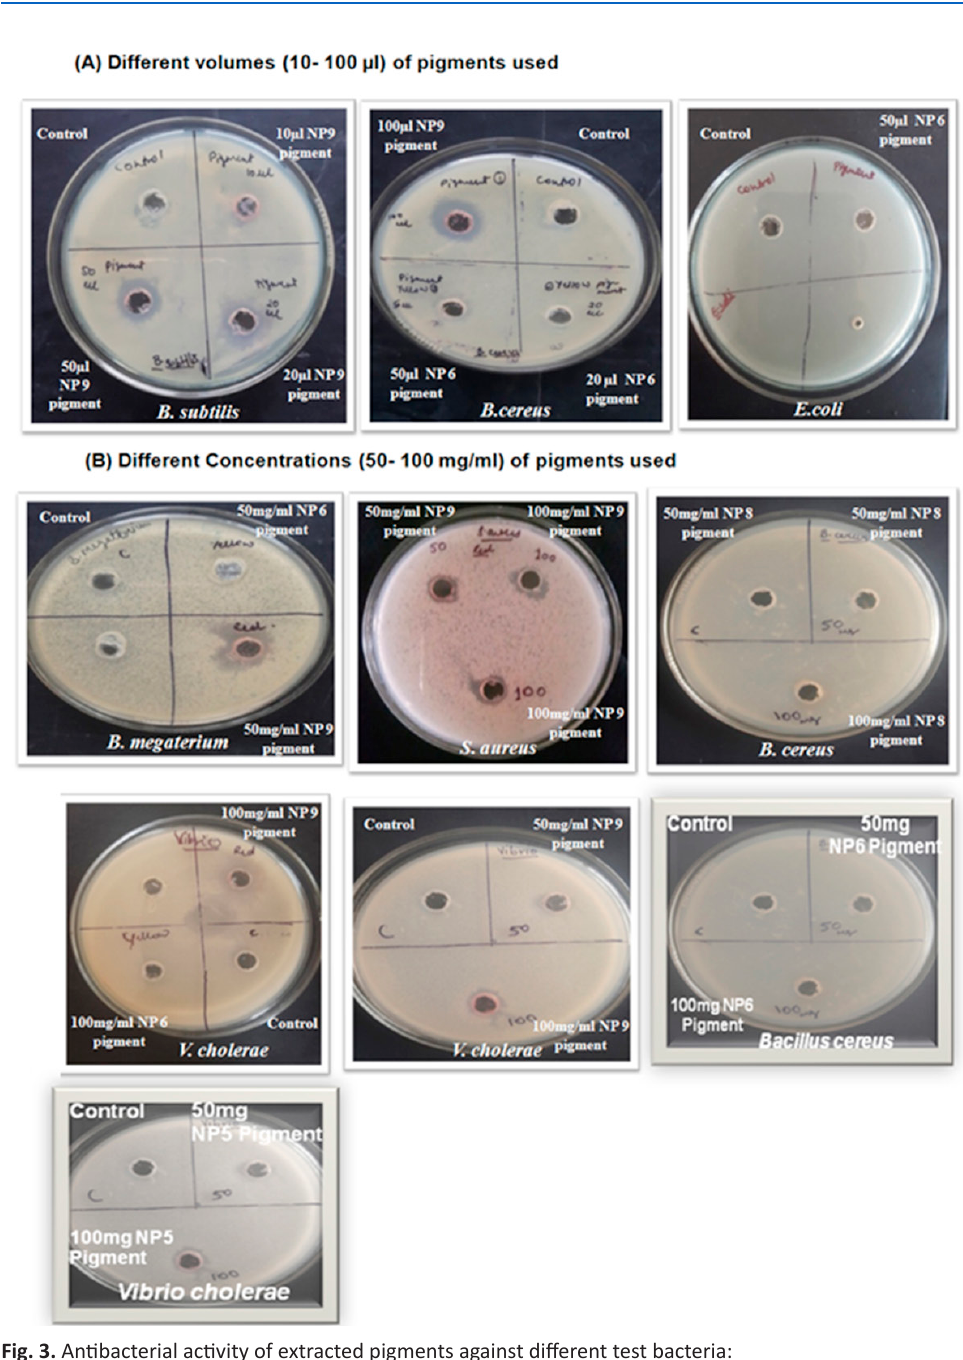
Fig. 3. Antibacterial activity of extracted pigments against different test bacteria: (A) Different pigments such as NP5(Orange), NP 6(Yellow), NP 8(Orange) and NP 9(Red) in different volumes were tested against different pathogens which shows inhibitory activity with increase in amount of pigment used against B. subtilis, B. cereus and E.coli . (B) At 50mg/ml concentration pigments showed minimum inhibitory activity against B. subtilis, B. cereus B. megaterium, S. aureus and V. cholerae but at 100mg/ml they showed larger zone of inhibition. NP 9(Red) pigment showed potent inhibitory activity as compared to NP 5(Orange), NP6 (Yellow) and NP8 (Orange)